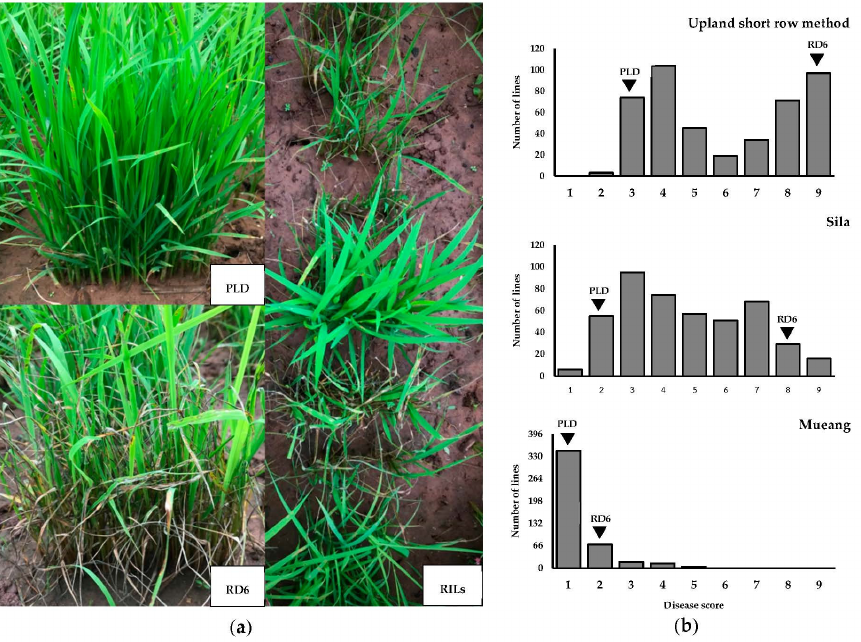
Figure 2. Blast ( BL ) phenotype in two parents and RILs: ( a ) the BL symptoms of the resistance parent PLD and susceptible parent RD6 and in RILs; ( b ) frequency distribution of disease reaction to a mixture of natural M. oryzae strains in 450 RD6/PLD F 6 RIL populations evaluated via USR method (top) and in two environments, Sila (middle) and Mueang (bottom). Disease scores of the parental lines (PLD and RD6) are indicated by a black